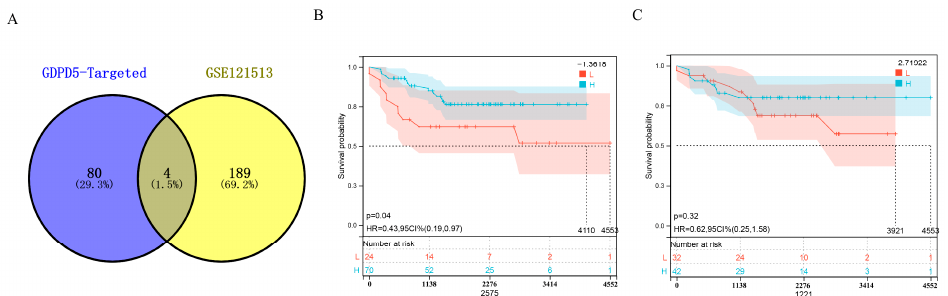
Figure 5. Identification of GDPD5-targeted miRNAs. ( A ) Venn diagram of differentially expressed